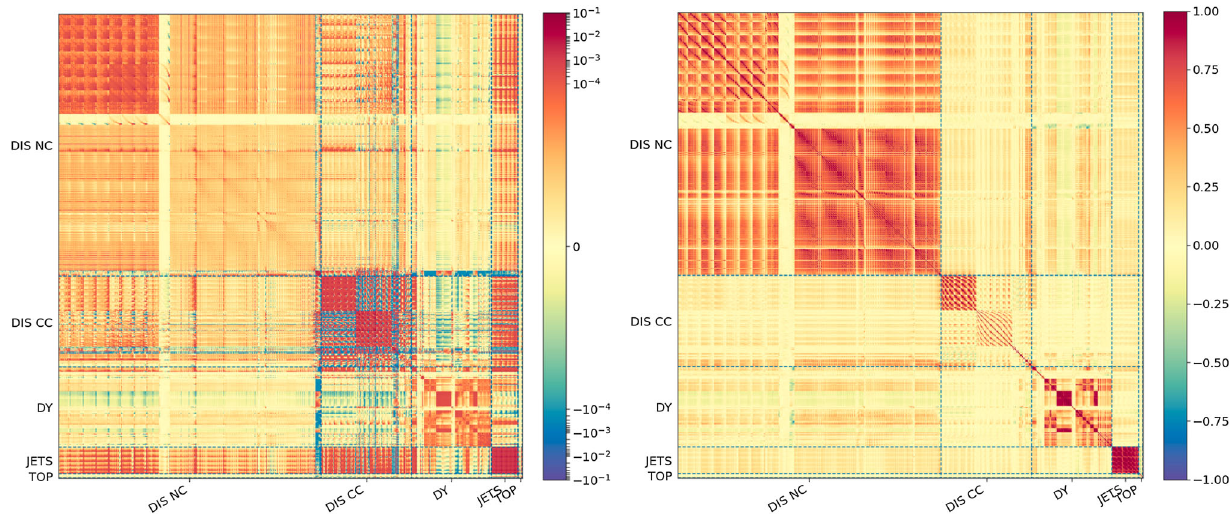
Fig. 8 The autoprediction covariance matrix P ij Eq. (4.33), normalized to the theoretical predictions T ( 0 ) (cid:12) P ii P jj (right) matrix P ij /